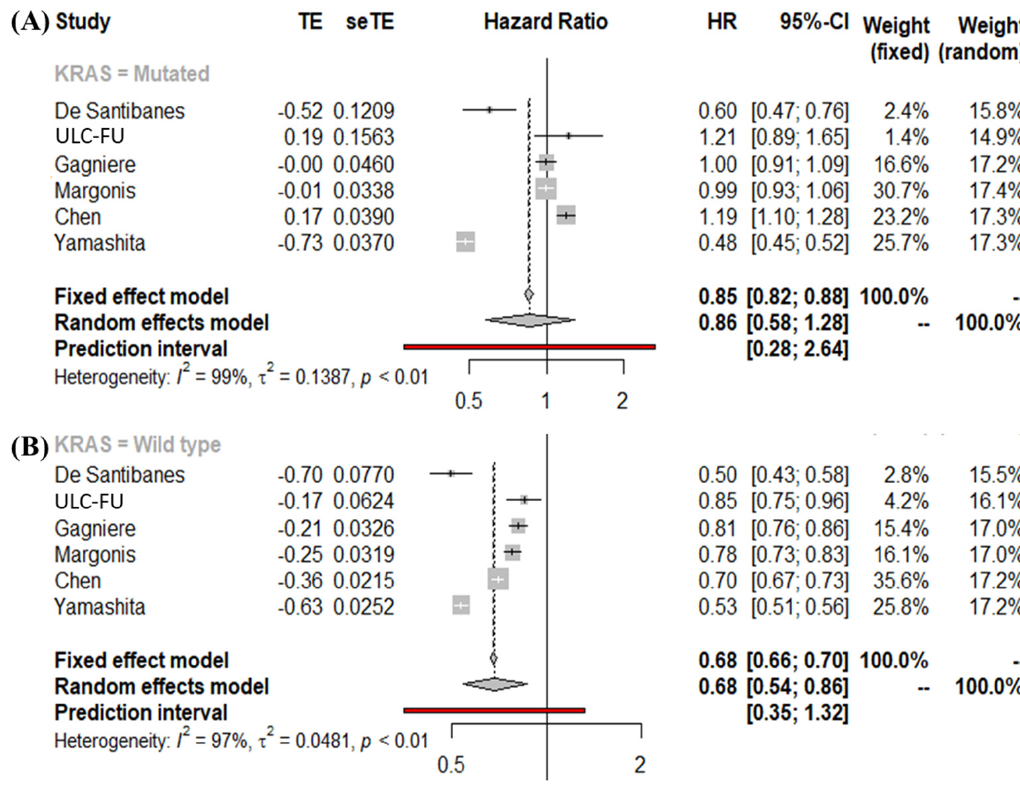
Figure 3. (A) Forest plot for right vs left (without rectum) in patients with KRAS-mutated tumors, (B) Forest plot for right vs left (without rectum) in patients with KRAS wild-type tumors; refer- ence: right side.